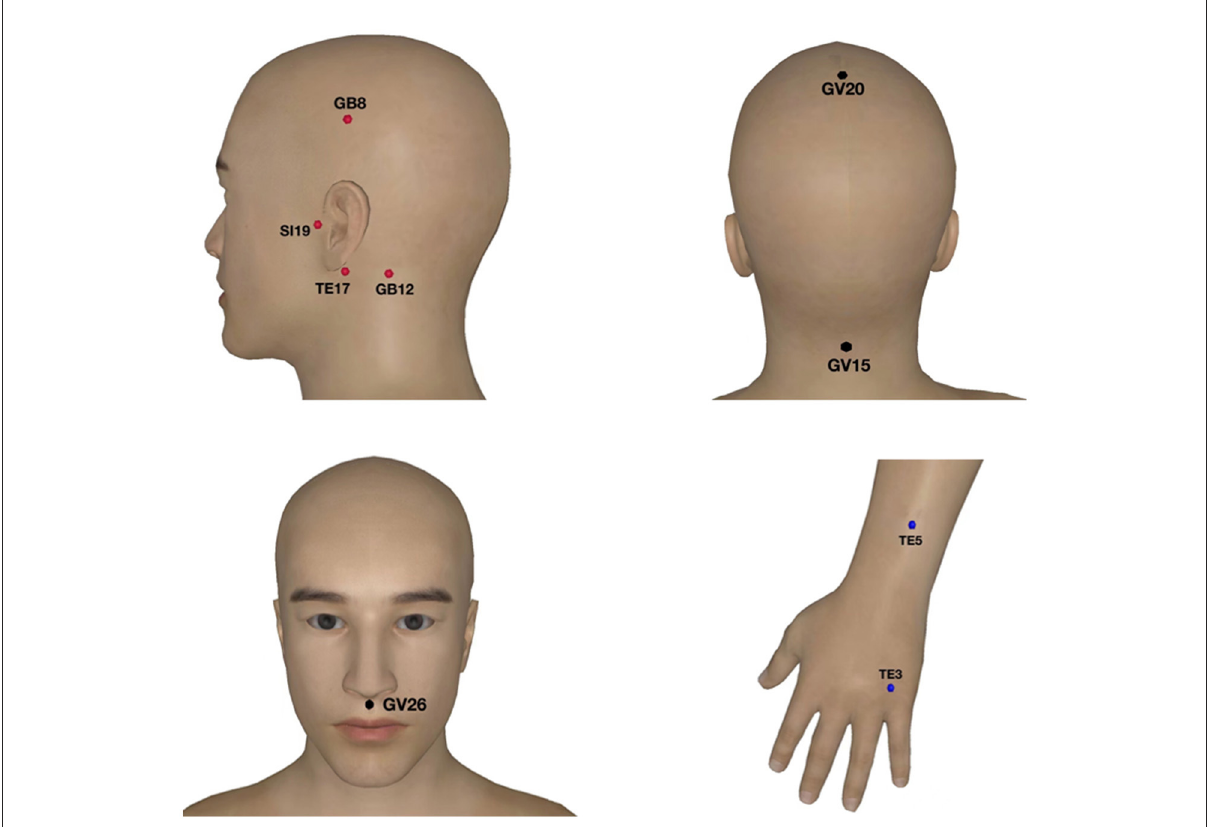
FIGURE1 Acupoints selected for acupuncture treatment of subjective tinnitus. The red points are the ones on the affected side of tinnitus, the blue are the distal bilateral acupoints and the black are the Governor Vessel